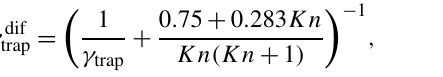
Figure 9. Molar fraction of HCl (gas phase partial pressure = 1 × 10 − 7 Torr) associated with ice particles (with a radius of 2, 6 and 18µm) considering either surface adsorption (Langmuir; zero ice growth) or trapping (ice growth velocity = 10nms − 1